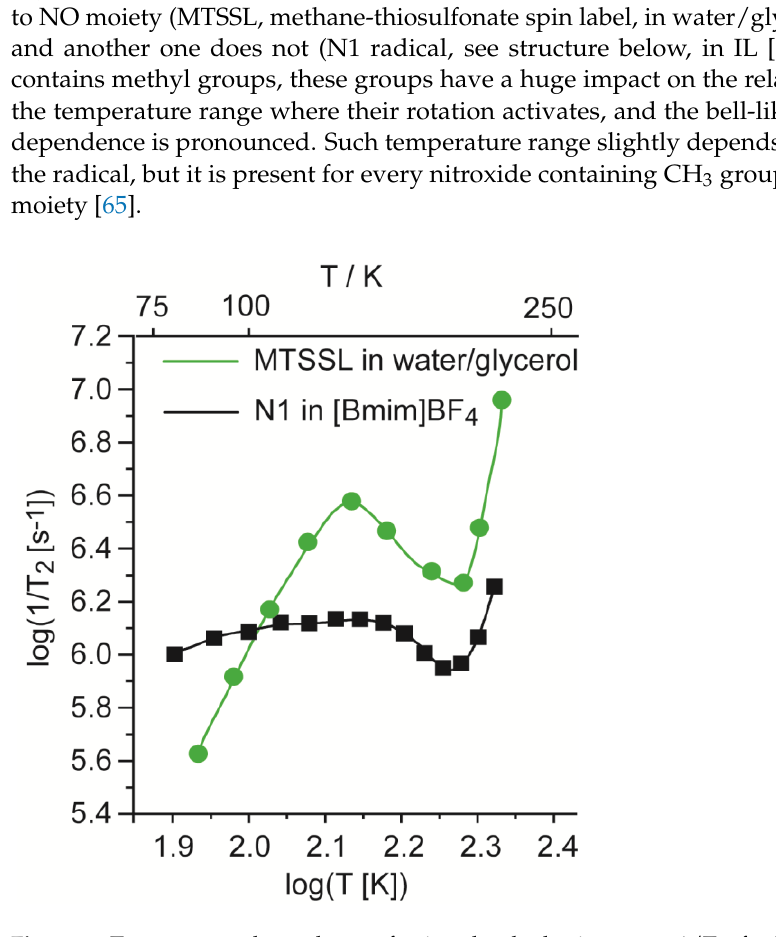
Figure 1. Temperature dependence of spin echo dephasing rates, 1/T 2 , for N1 dissolved in ionic liquid [Bmim]BF 4 (black squares, adapted from Ref. [56]) and for MTSSL in water/glycerol (1:1) mixture (green circles, adapted from Ref. [63]) measured at the maximum of echo-detected spectrum, position I in Figure 2a below.